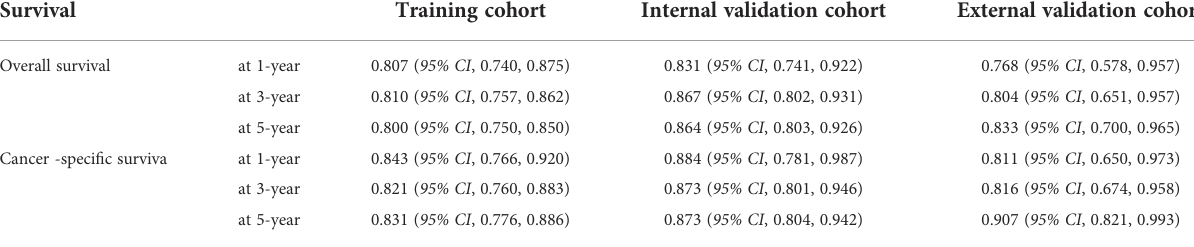
TABLE 4 AUC for the Nomogram in patients with Colorectal GISTs.